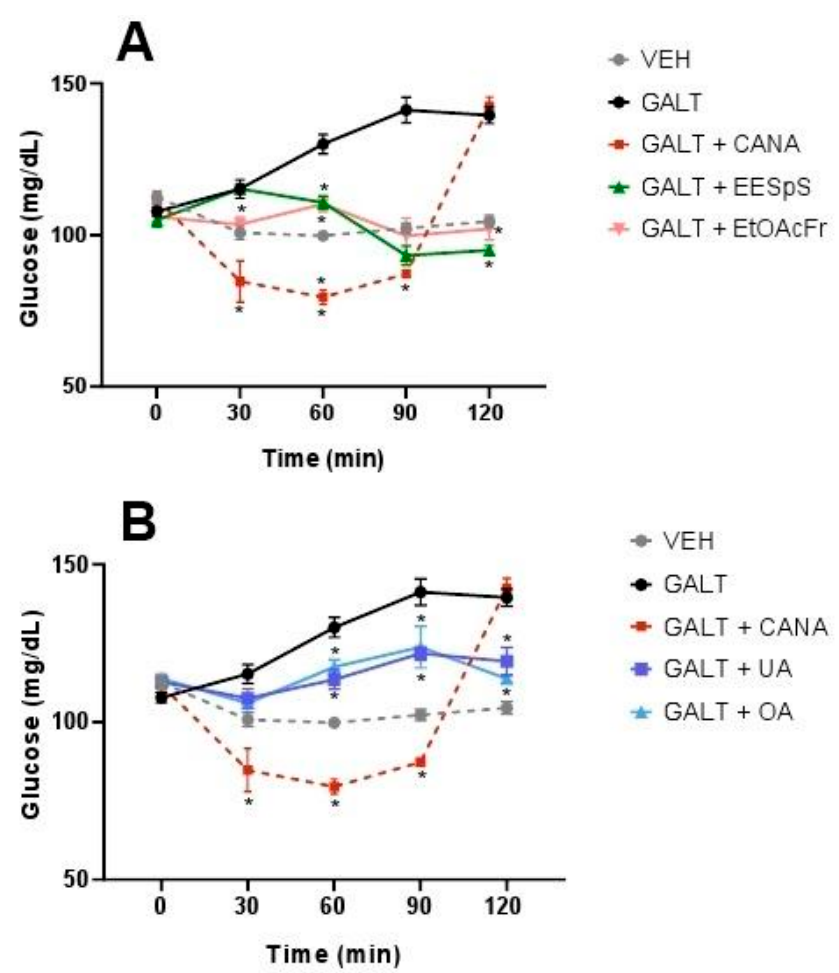
Figure 5. Effect of products obtained from the stems from S. polystachya in oral glucose tolerance test (OGaTT). ( A ) OGaTT of groups treated with galactose, acarbose, EESpS and EtOAcFr, as well as vehicle. ( B ) OGaTT of groups treated with galactose, acarbose, UA and OA, as well as vehicle. Results shown as mean ± SEM ( n = 6). * p > 0.05 significantly different vs. galactose group values at the same time. (Two-way ANOVA followed by Dunnett post hoc test) ACAR: acarbose; GALT: